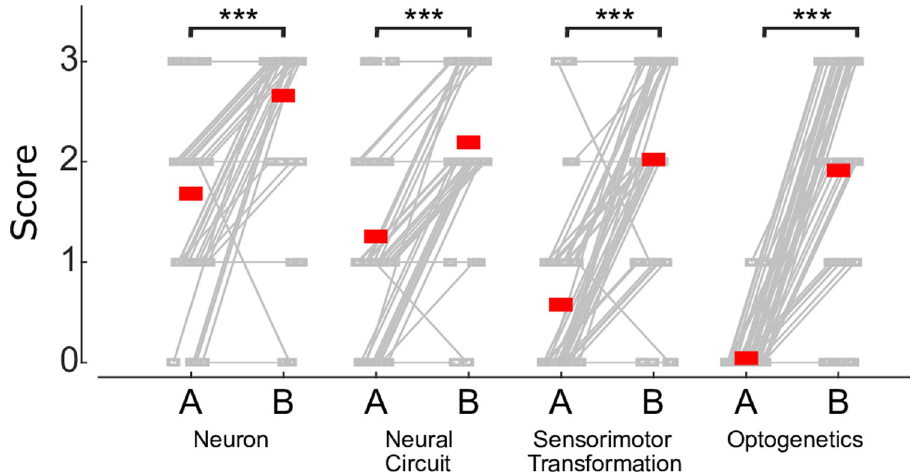
Fig 4. Workshop assessment outcomes. A total of 47 students distributed over three workshops were evaluated on four concepts, both before and after the workshop. Gray connected boxes indicate individual student scores and red squares indicate averages (Wilcoxon signed rank test, ��� = p << 0.001). Abbreviations: quiz administered before the workshop (B); quiz administered after the workshop